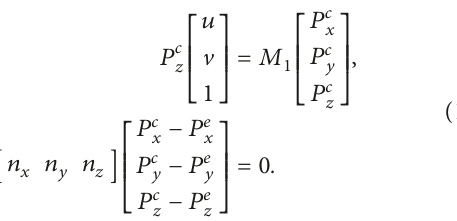
Figure 5: The binocular camera.